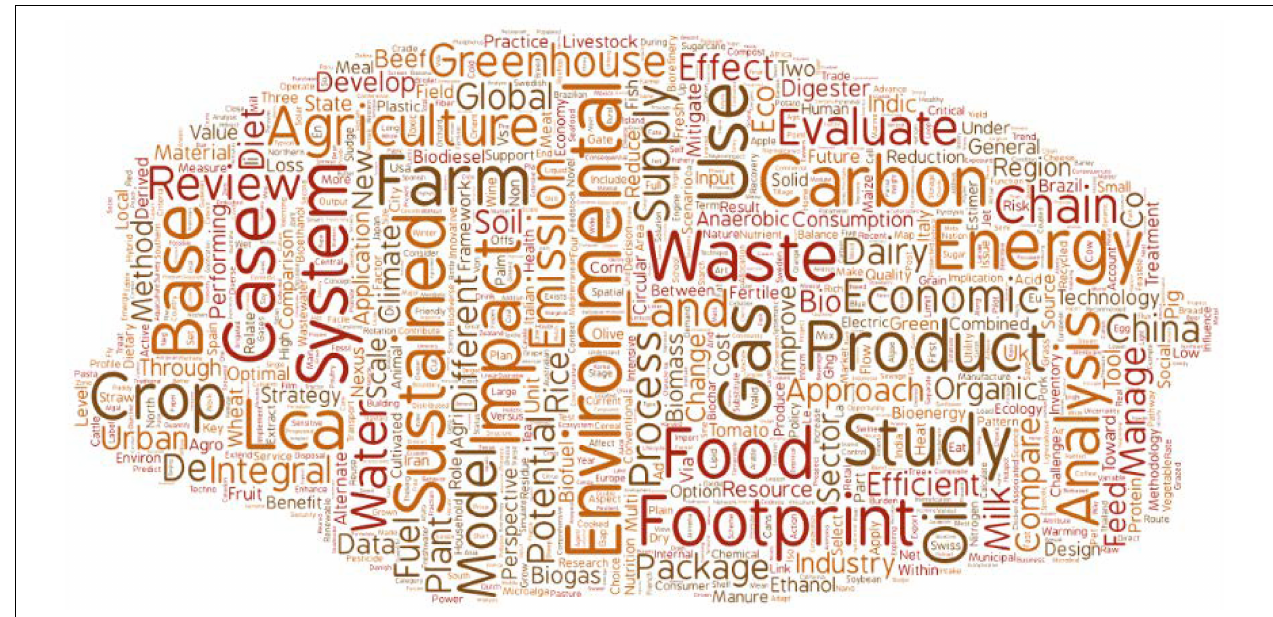
FIGURE 1 | Word cloud of most frequent words in the titles of 4,131 papers containing life cycle assessment together with agriculture or food in their title, abstract or keywords. Created with WordArt and Scopus on 1 March 2022.